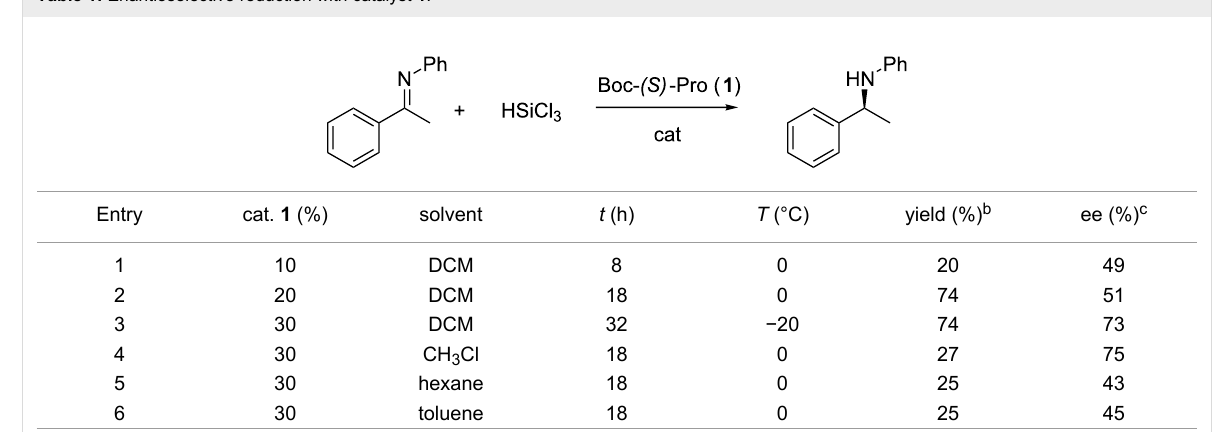
Table 1: Enantioselective reduction with catalyst 1 .